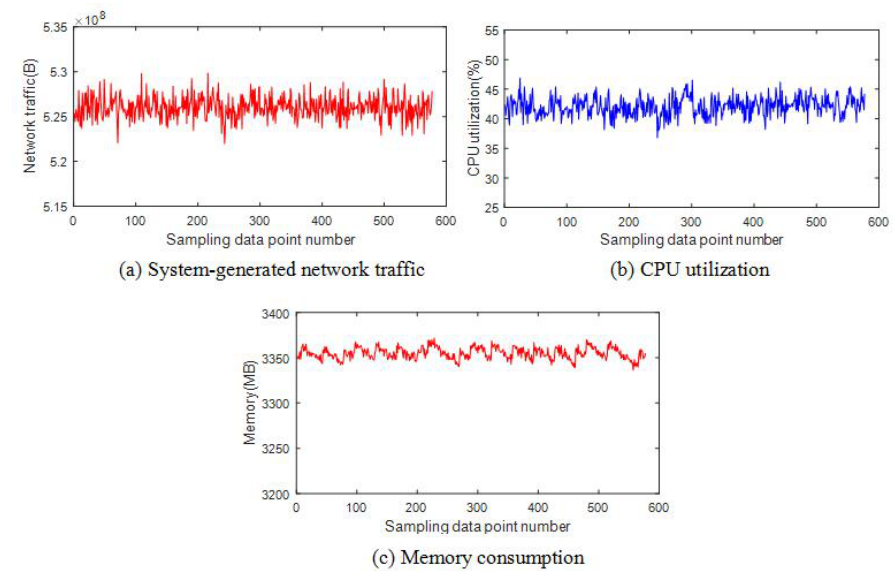
Figure 17. The stability of the system.